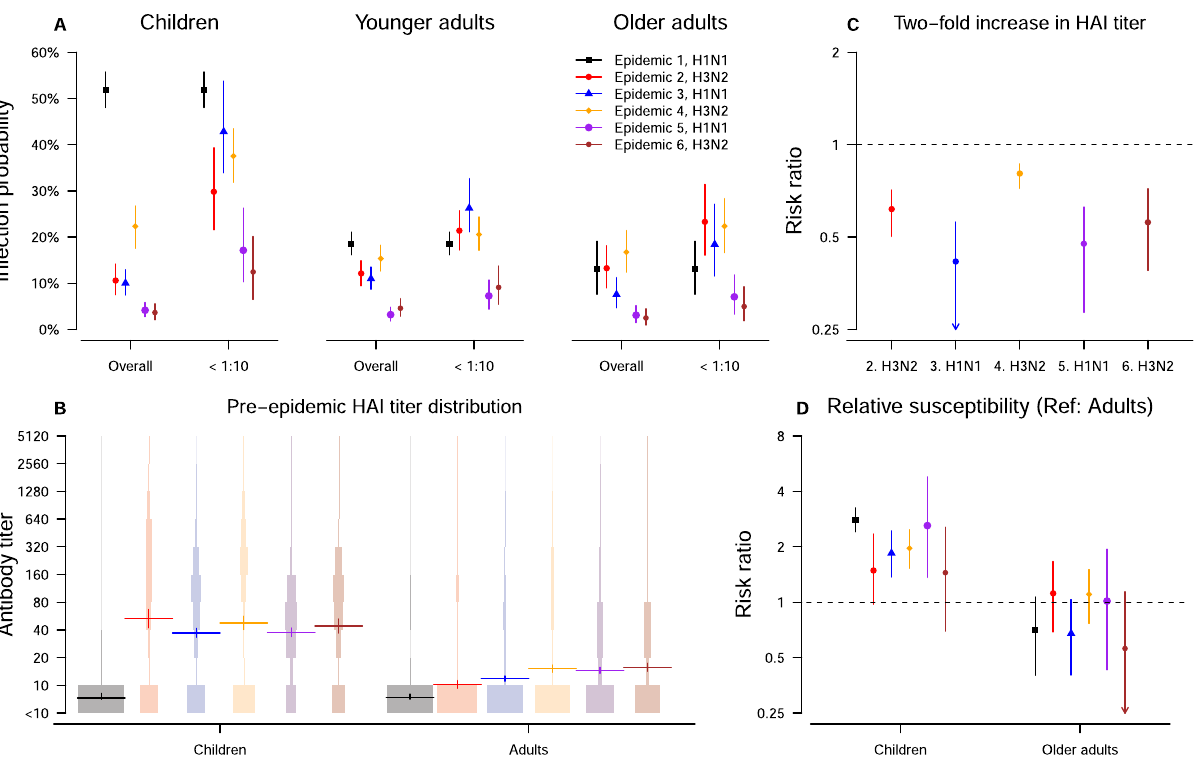
Fig. 2 Infection probability and its determinant among six epidemics. A Estimates of infection probabilities for children, younger adults and older adults in the six epidemics in our study period. The overall infection probability and infection probability for individuals with pre-epidemic titer of <10 are plotted to show the protective effect of pre-epidemic titers. Points and vertical lines are used to show the mean and corresponding 95% credible intervals of the estimates based on our estimation approach fi tted to data with 2353 individuals. B The protection associated with 2-fold increase in HAI titers in epidemic 2 – 6. Points and vertical lines are used to show the mean and corresponding 95% credible intervals of the estimates based on our estimation approach fi tted to data with 2353 individuals. C The pre-epidemic HAI titer distribution for children and adults in the six epidemics. Funnel plots are used to show the distribution. Points and vertical lines are used to show the mean and corresponding 95% credible intervals of the estimates based on our estimation approach fi tted to data with 2353 individuals. D Model estimate of the age-relative susceptibility for six epidemics. Points and vertical lines are used to show the mean and corresponding 95% credible intervals of the estimates based on our estimation approach fi tted to data with 2353 individuals.